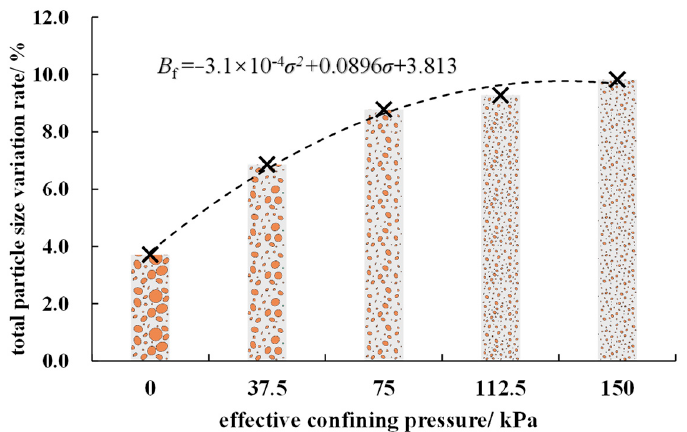
Figure 14. The effect of effective confining pressure on the total particle size of silt.